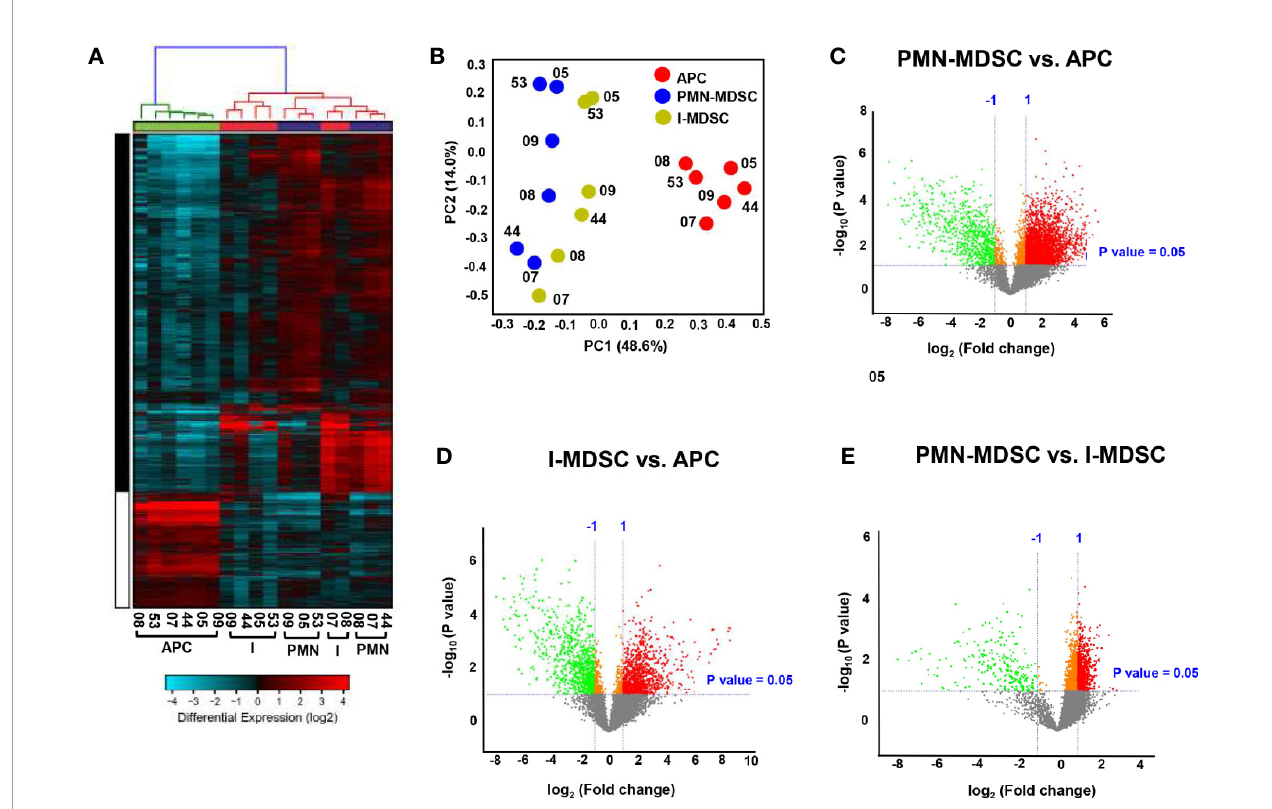
FIGURE 2 | Hierarchical clustering and comparison of myeloid cell subpopulations (PMN-MDSCs, I-MDSCs and APCs) in tumor tissue of CRC patients. Cells isolated from tumor tissues of six CRC patients were stained for myeloid cell markers and sorted for RNA extraction. Hierarchical clustering of APCs, I-MDSCs and PMN-MDSCs from six tumor tissues (CRC patients #05, 07, 08, 09, 44 and 53) based on differentially-expressed RNA transcripts. Each column represents a sample and each row represents a transcript. Expression level of each gene in a single sample is depicted according to color scale (A) . Principle component analysis (PCA) based on the differentially expressed genes in each myeloid subpopulation (B) . Volcano plots show genes that were upregulated (shown in red), downregulated (shown in green) or remained unchanged (shown in grey) when comparing PMN-MDSC vs. APC (C) , I-MDSC vs. APC (D) and PMN-MDSC vs. I-MDSC (E)